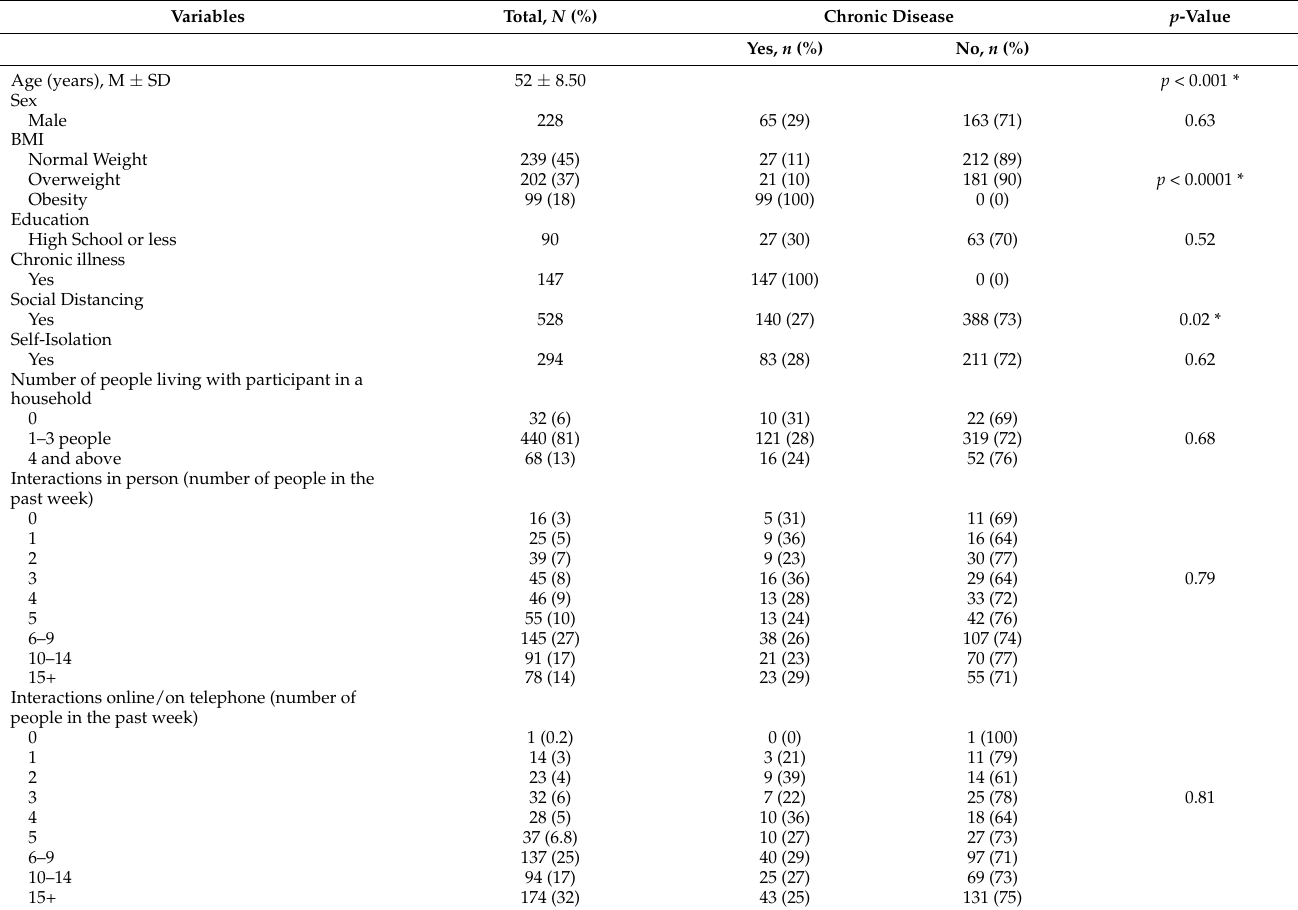
Table 1. Descriptive analysis of the sample ( n =